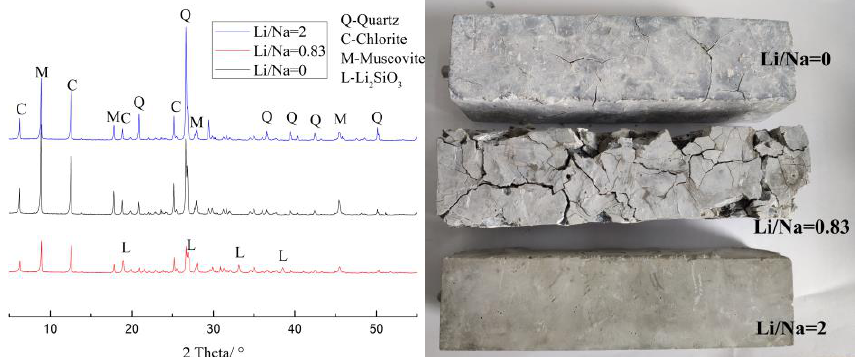
Figure 6. XRD patterns of aggregates in concrete microbars and images of corresponding concrete microbars cured in different alkaline solutions at 80 ◦ C.